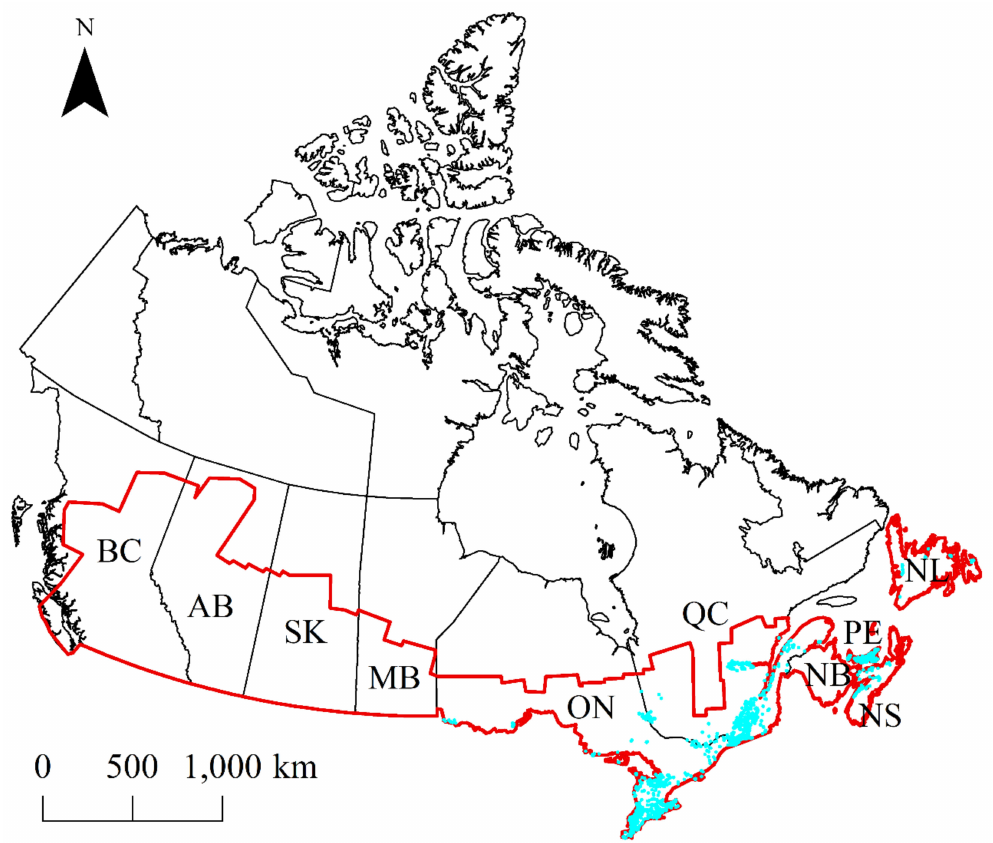
Figure 2. The study area (red boundary) within Canada’s boundary (black boundary). The field samples are indicted by cyan color Note that since ground observations for the western Provinces are collected by Provincial Crop Insurance companies, they were unavailable for this study.